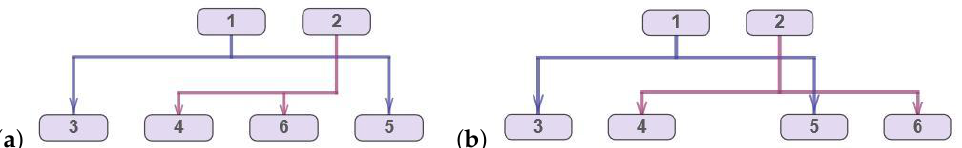
Figure 2. Reordering nodes on the lower layer of a graph leads to a decrease in the number of edge crossings: two crossings for the layout ( a ) and one crossing for the layout ( b ).